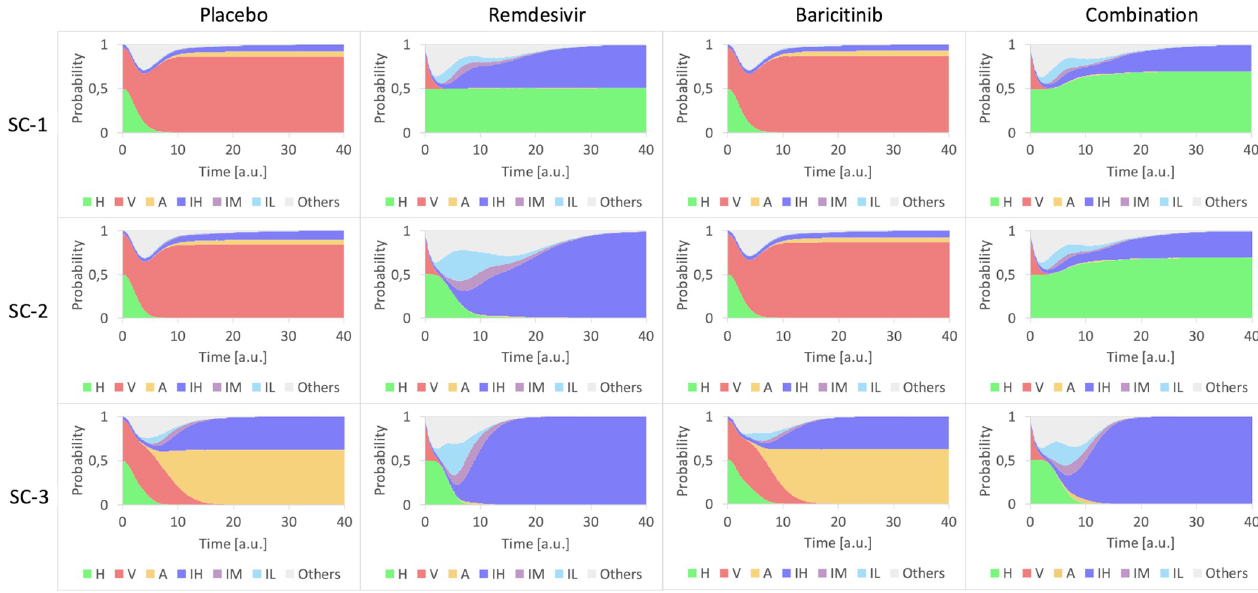
Fig 4. Temporal dynamics for Remdesivir, Baricitinib and their combination expressed as the probability to reach the most frequent phenotypes. Each row corresponds to a scenario, and each column to a treatment. The initial conditions correspond to 50% of healthy cells, and the remaining percentage proportionally distributed between the different untreated stable states (45.9% infected cells, 4.1% inflamed cells). The colored area represents the probability of each phenotype. Simulations were performed with MaBoSS [37].